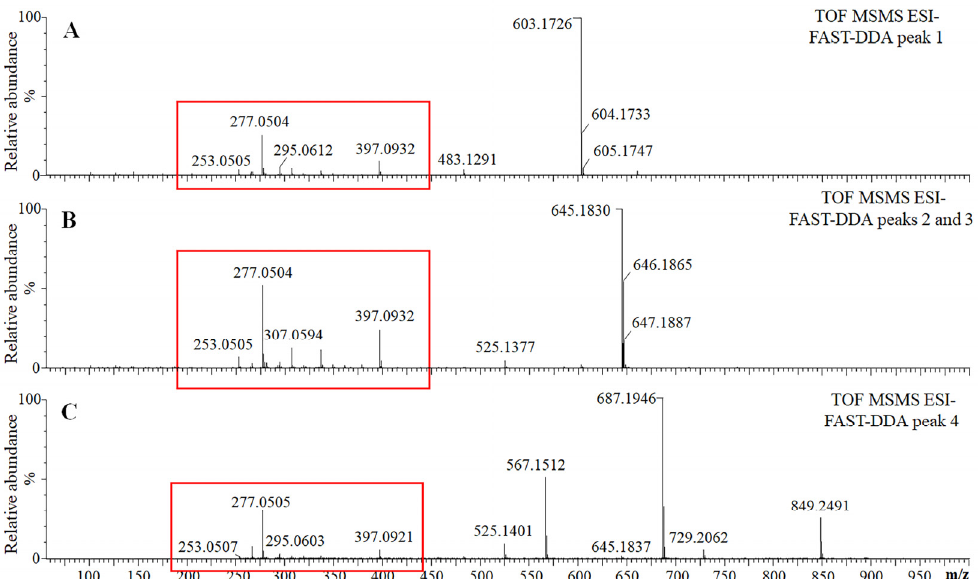
Figure 4. FAST-DDA analysis of four unidentified compounds. The analysis of compounds 1 ( A ), 2 and 3 ( B ), and 4 ( C ) showed that compounds 2 and 3 share the same m/z value (645.1820) but eluted at 8.82 and 9.06 min, respectively. Red boxes indicate the same core structure among the four compounds.